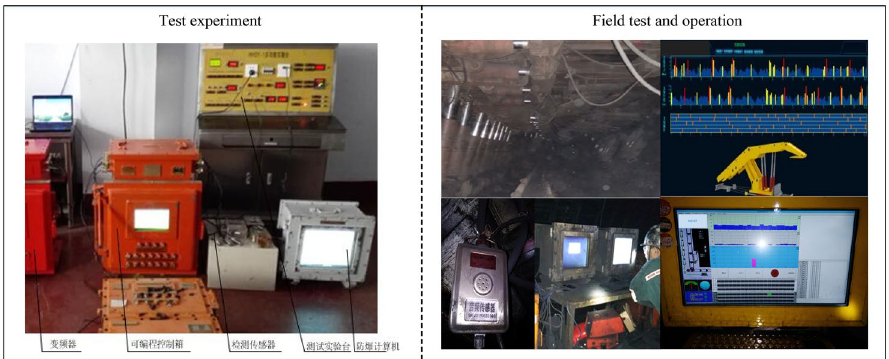
Figure 12. Data collection and operation in top coal caving production